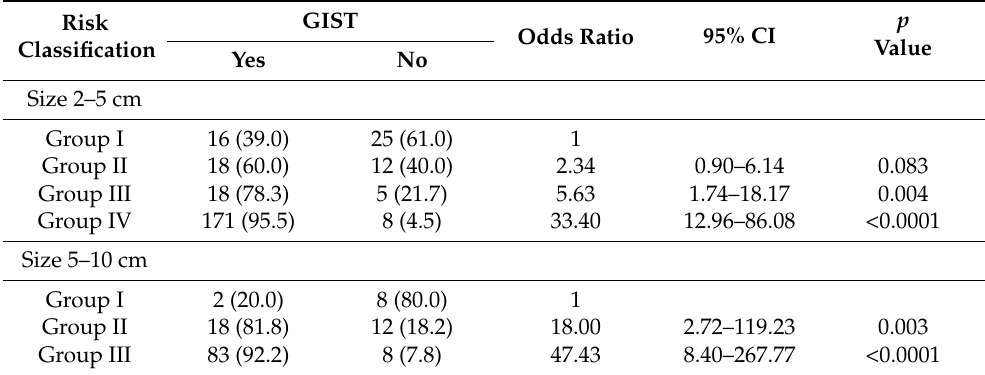
Table 4. Risk classification according to the results of the recursive partitioning